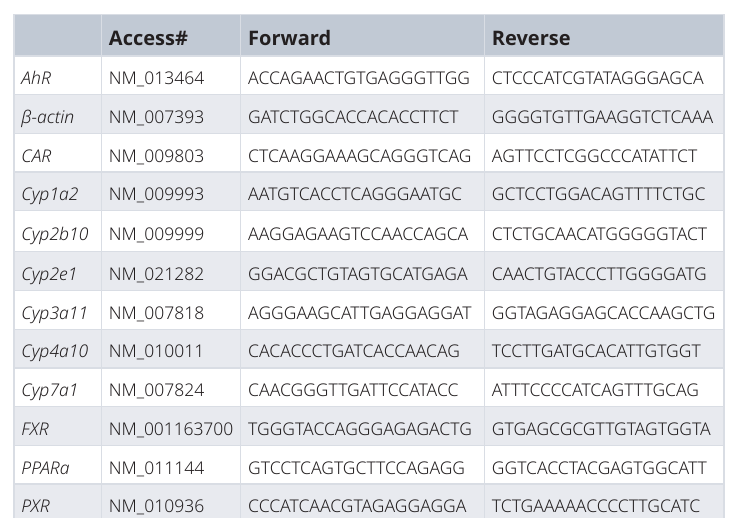
Table 1. Primer sequences for real-time